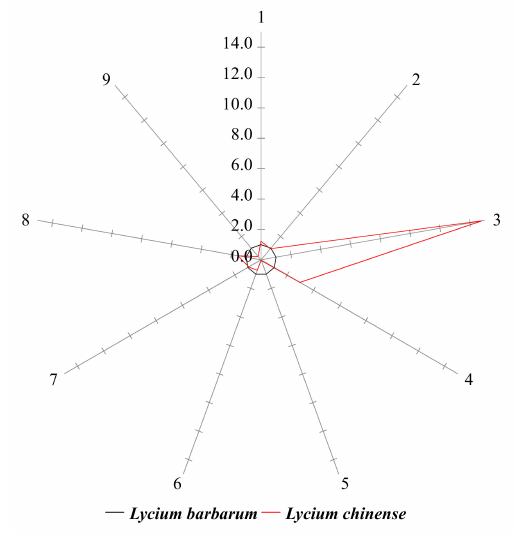
Figure 3. Phenolic acid star symbol plot of the normalized values in Table 2. The numbers on the rays correspond to the row no. in Table